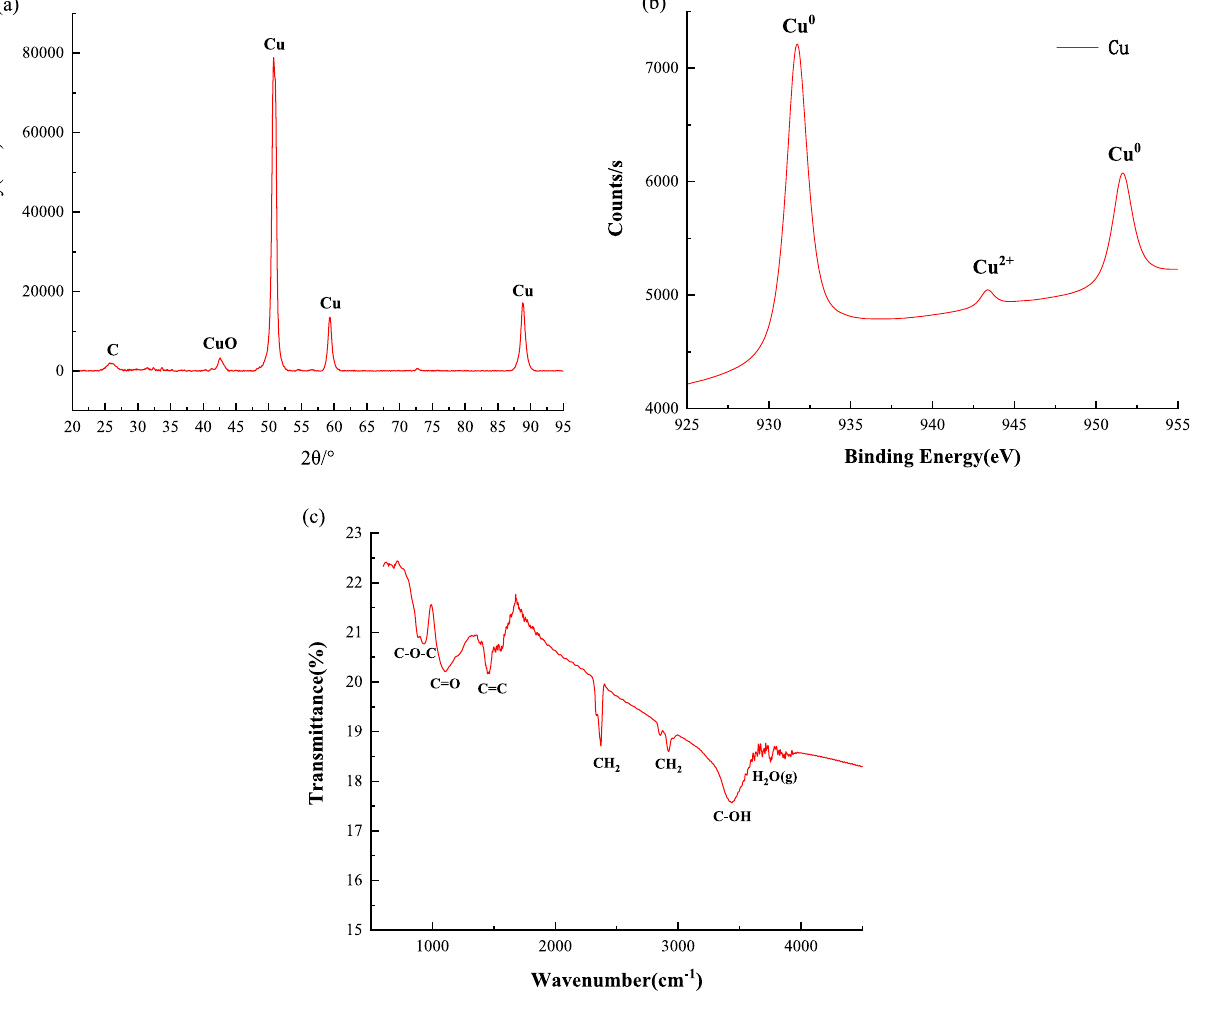
Figure 1. ( a ) XRD pattern of ZVC/CTS-ACB. ( b ) XPS of ZVC/CTS-ACB. ( c ) FT-IR of